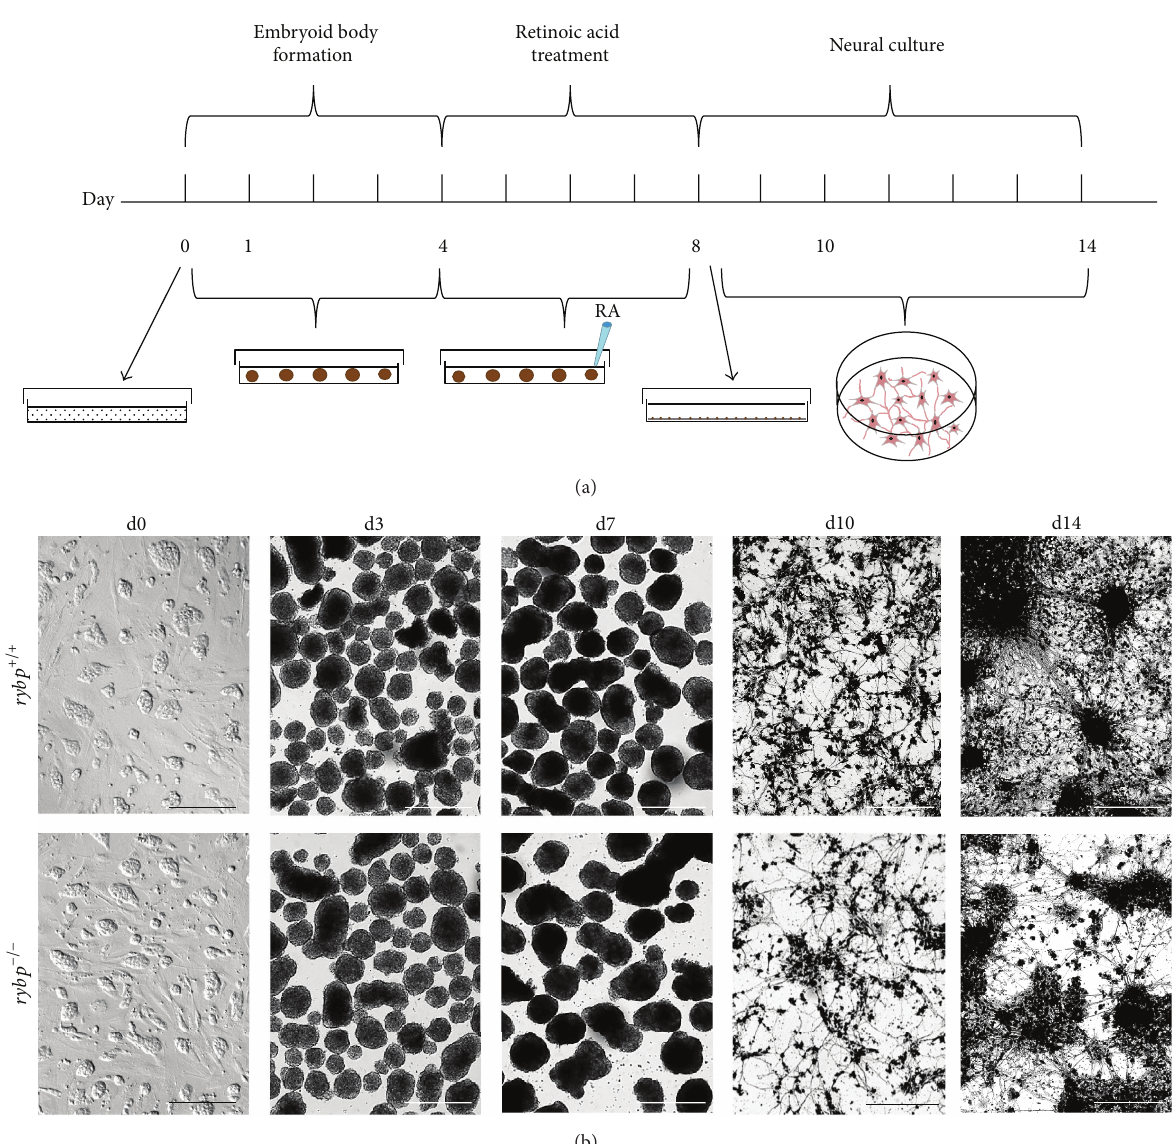
Figure 1: Morphological changes of 𝑟𝑦𝑏𝑝 +/+ and 𝑟𝑦𝑏𝑝 −/− cells through in vitro neural differentiation. (a) Schematic illustration of in vitro neural differentiation as described previously by Bibel et al. (b) The 𝑟𝑦𝑏𝑝 −/− ESCs display the same morphology in culture as the wild type (d0) and also form EBs (d3, d7). There is no noticeable difference between the two cell lines. After the plating (d10, d14) the 𝑟𝑦𝑏𝑝 −/− cells grew less organized neural network than the wild type. Magnifications are 4x (d3, d7) and 10x (d0, d10, d14). Scale bars represent 500 𝜇 m (d3, d7) and 200 𝜇 m (d0, d10,